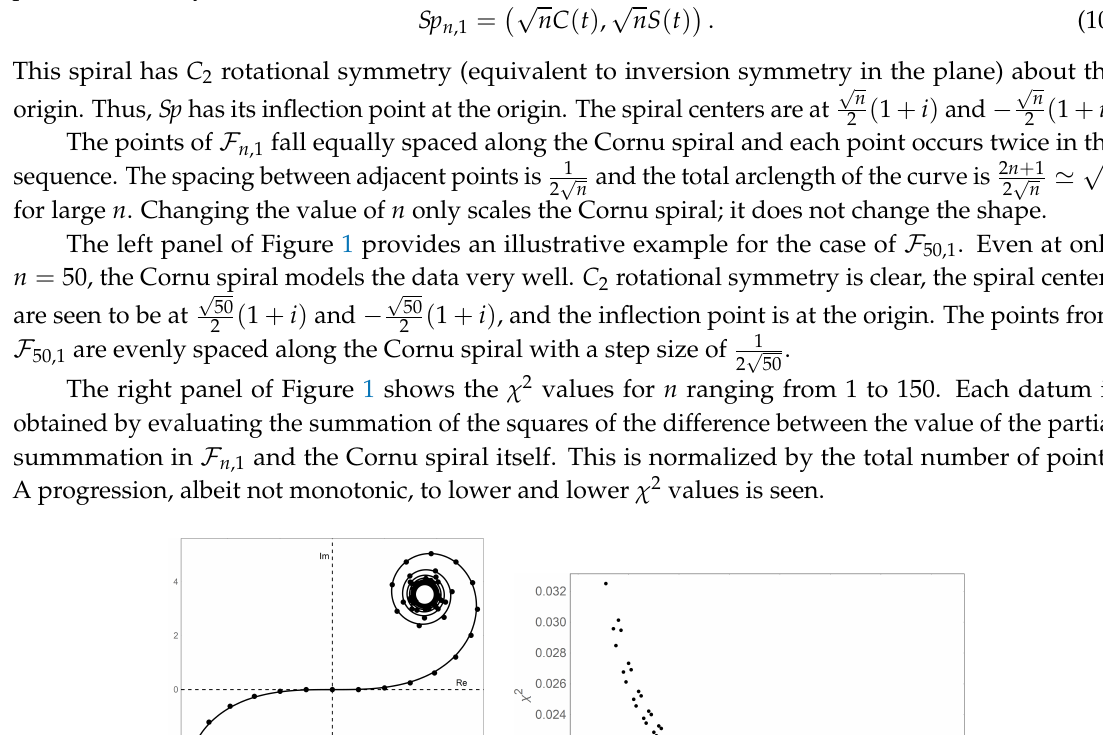
√ . Right panel: χ 2 values for n = 1 to n 2